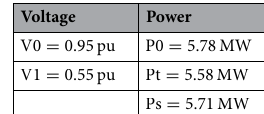
Table 17. Voltage and power values in the selected points of the graphs.